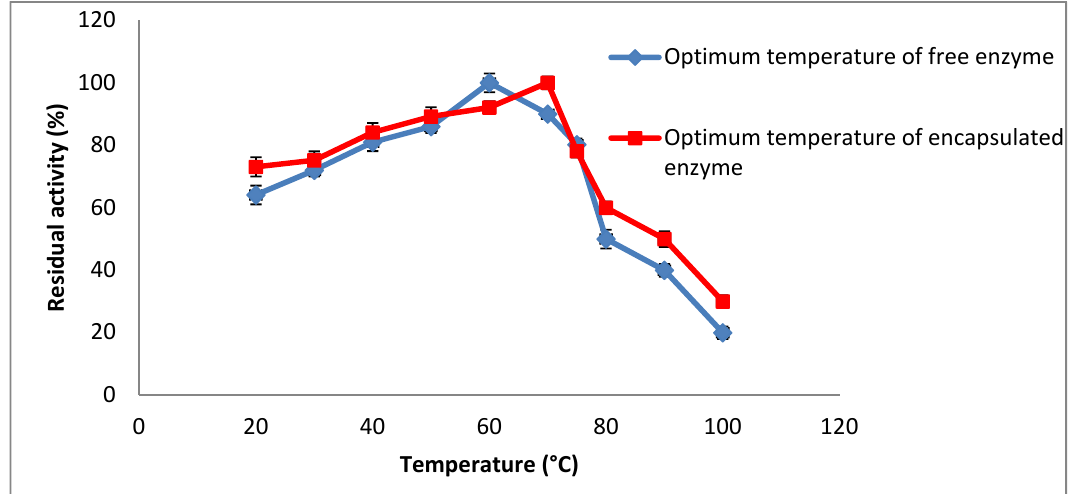
Figure 3. Effect of temperature on enzyme residual